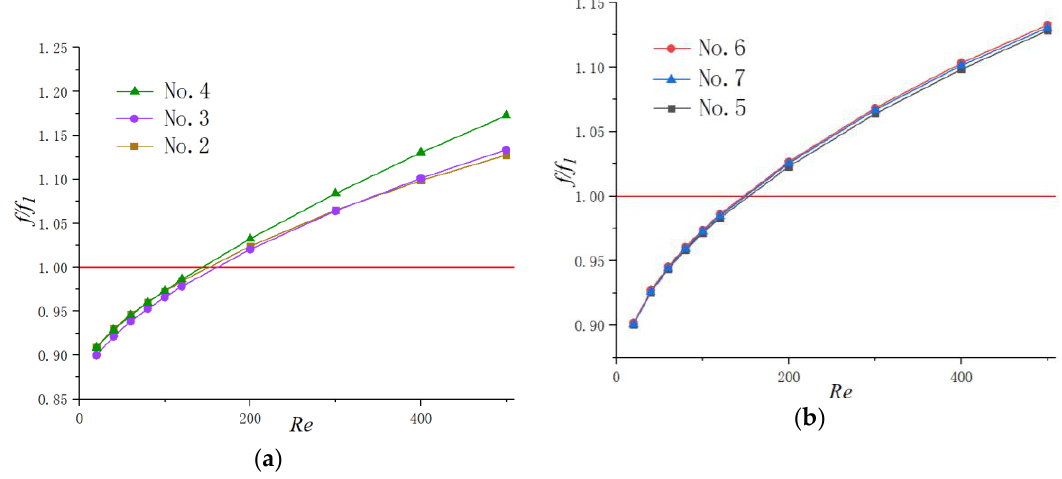
Figure 5. Variation of 𝑓/𝑓 1 with Re. ( a ) Group 1, ( b ) Group 2.